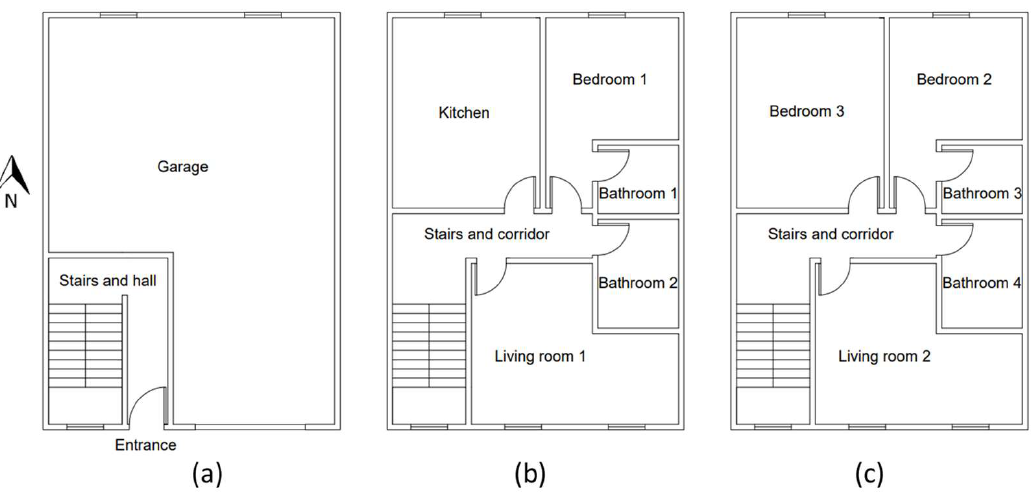
Figure 3. Layout of all the study building floors: ( a ) ground floor, ( b ) first floor and ( c ) second floor.